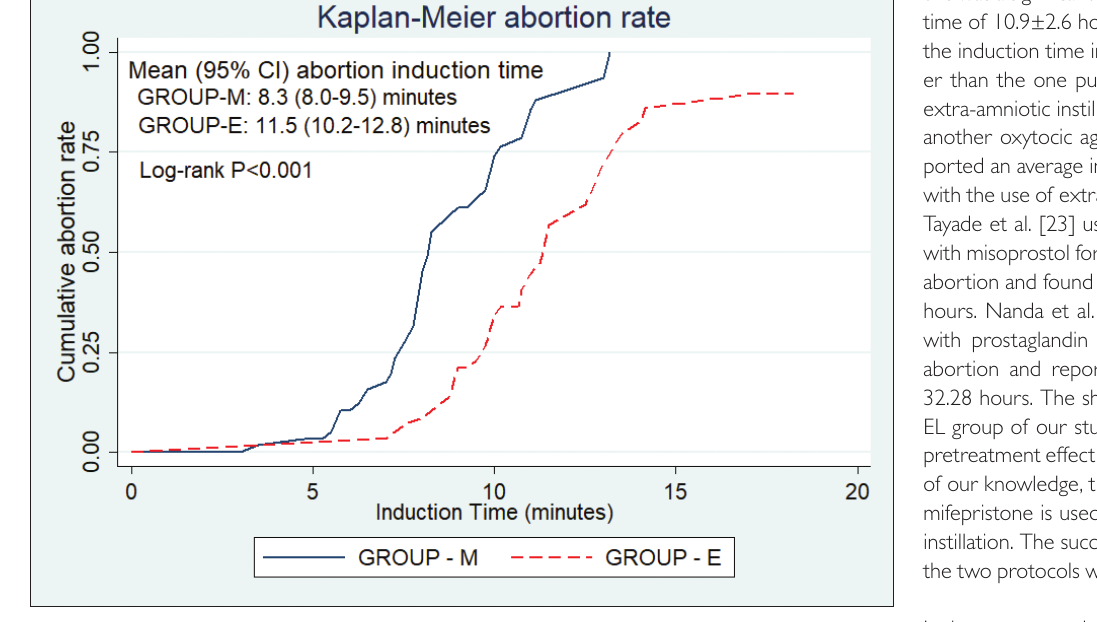
Figure 2. The Kaplan–Meier time curve for the induction-to-abortion time. Table 1. Demographics of women undergoing pregnancy termination